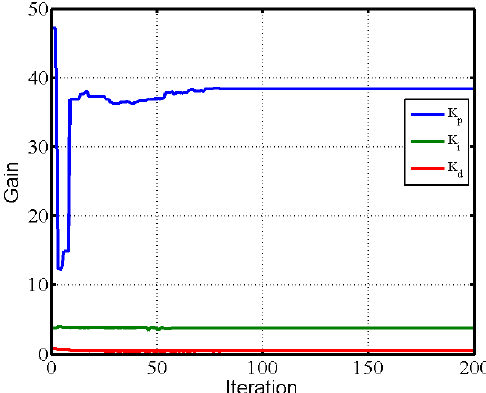
Figure 13. Evolutionary curve of estimated parameters ( K p , K i , K d ) for FOPID controller with operator.